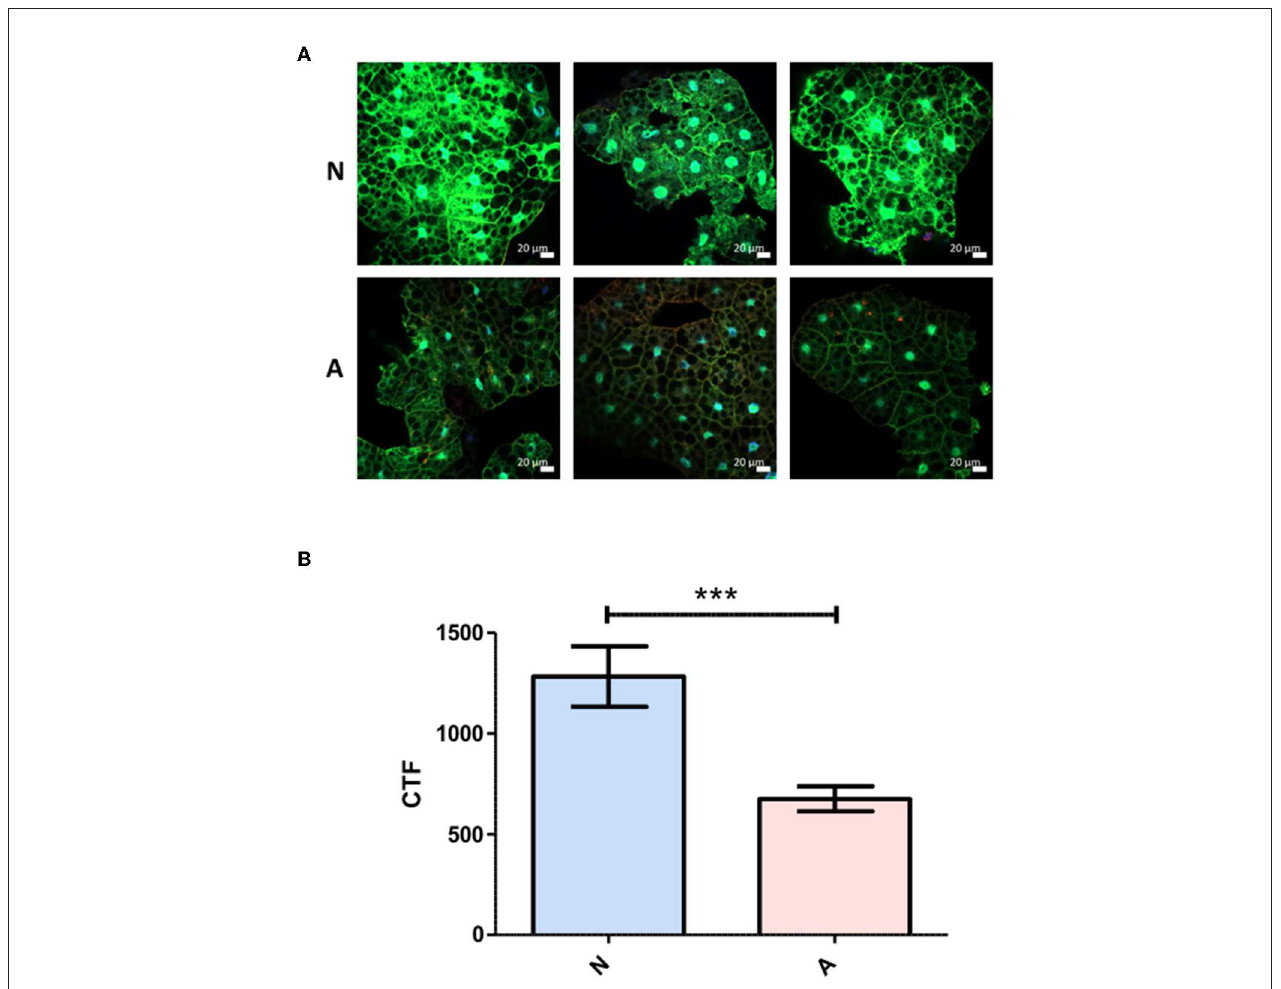
FIGURE 3 | Differential Diptericin responses to ES products originate at or prior to transcriptional activation. (A) Larvae of a Drosophila melanogaster line carrying GFP under the control of the antimicrobial peptide Diptericin promoter were injected with 50.2 nl of non-activated (N) or activated (A) products. The fat body was extracted at a 6-h time point and imaged via confocal microscopy. One representative image from each of the three trials is shown for both treatments. (B) Corrected total fluorescence was assessed for isolated green channels with Image J software (*** p < 0.001). Values were calculated for 10 images per treatment per